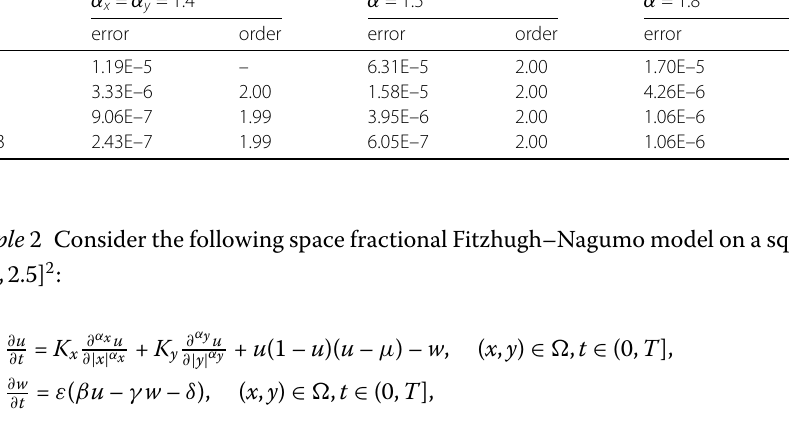
Table 2 The temporal errors and convergence order for CIIF2 scheme in Example 1 α x = α y = 1.4 α = 1.5 α = 1.8 τ error order error order